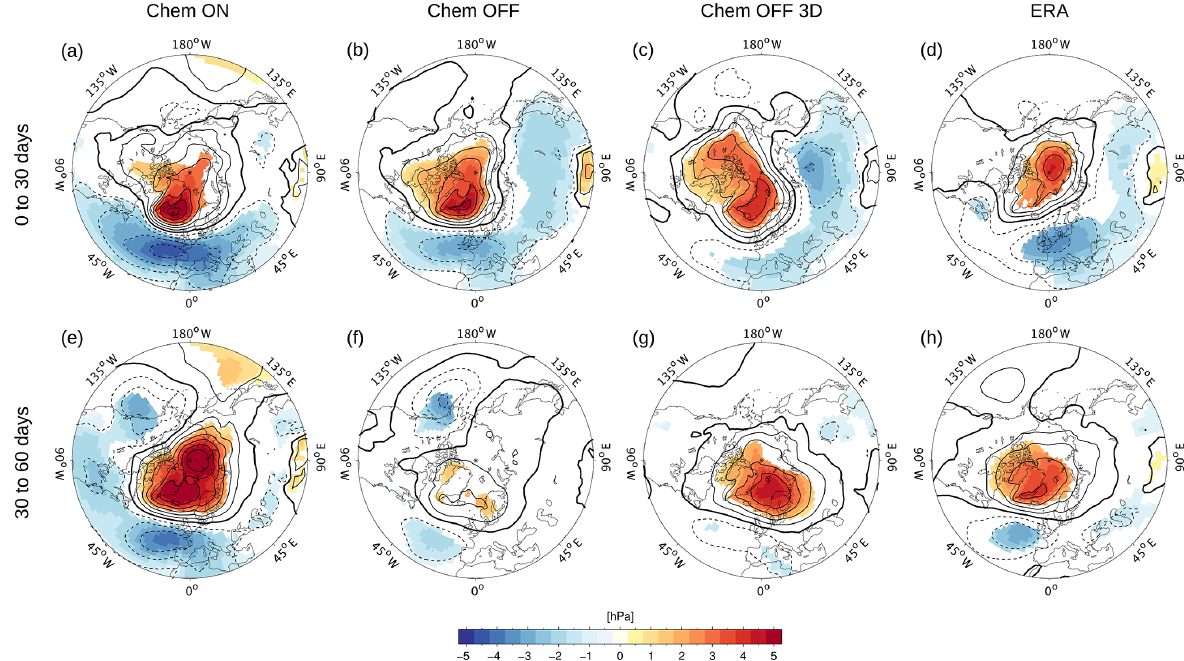
Figure 9. SSW composite of SLP anomalies in hPa averaged over 0 to 30 days (a, b, c, d) and over 30 to 60 days (e, f, g, h) following the central date of the SSW for (a) and (e) Chem ON, (b) and (f) Chem OFF, (c) and (g) Chem OFF 3D, and (d) and (h) combined ERA data. Contour lines show the full composites, whereas only statistically significant areas at the 95% level are colored. Solid contours are used for positive values, and dashed contours are used for negative values. The zero contour is a bold solid line. The contour line interval is